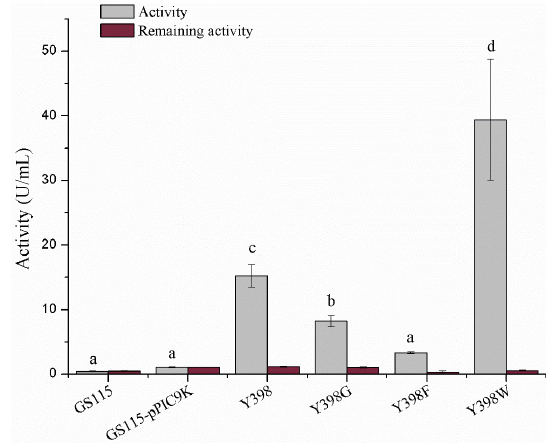
Figure 3. Enzymatic activity and inhibition by physostigmine. GS115 and GS115-pPIC9K refer to the supernatant of Pichia p. GS115 without pPIC9K plasmid and Pichia p. GS115 with pPIC9K but no